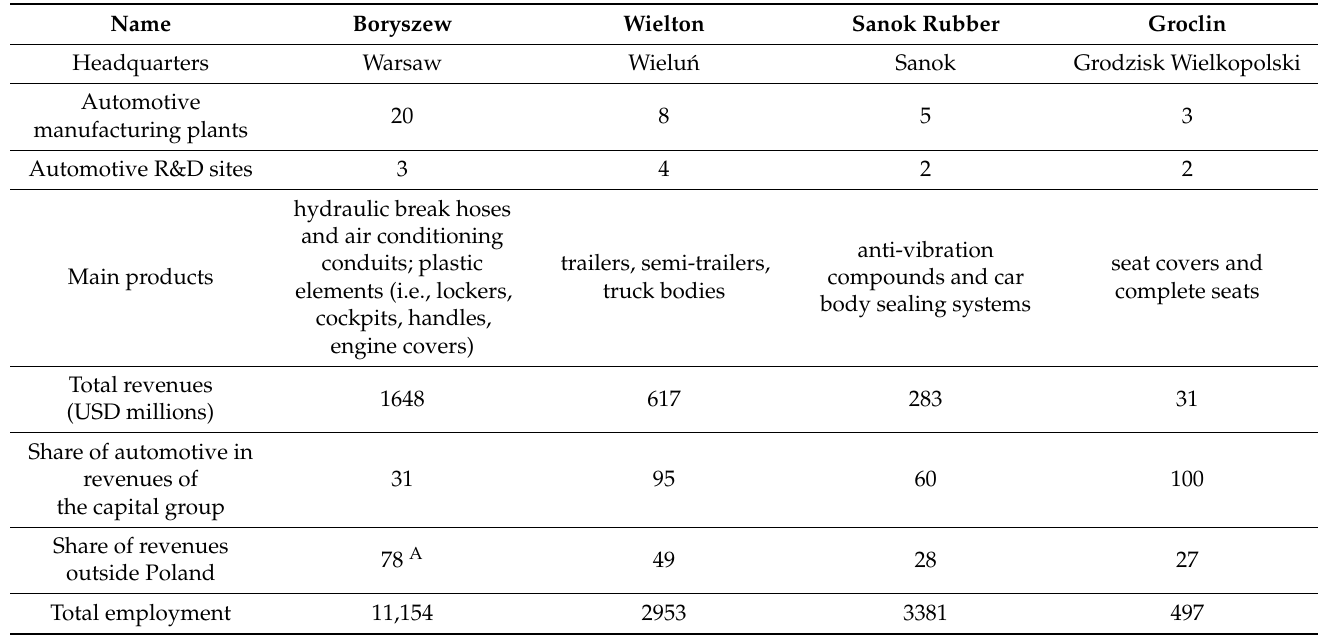
Table 1. Characteristics of the discussed Polish multinational automotive companies in